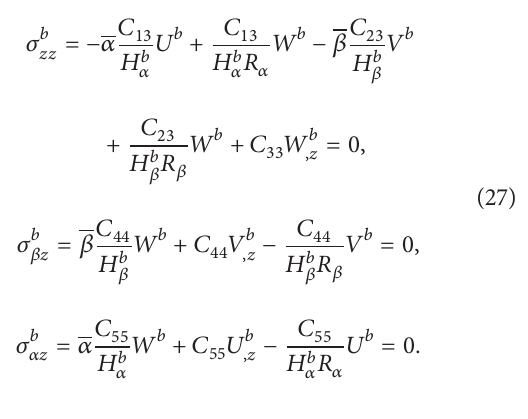
0 of the shell, and ̃𝑧 = 0